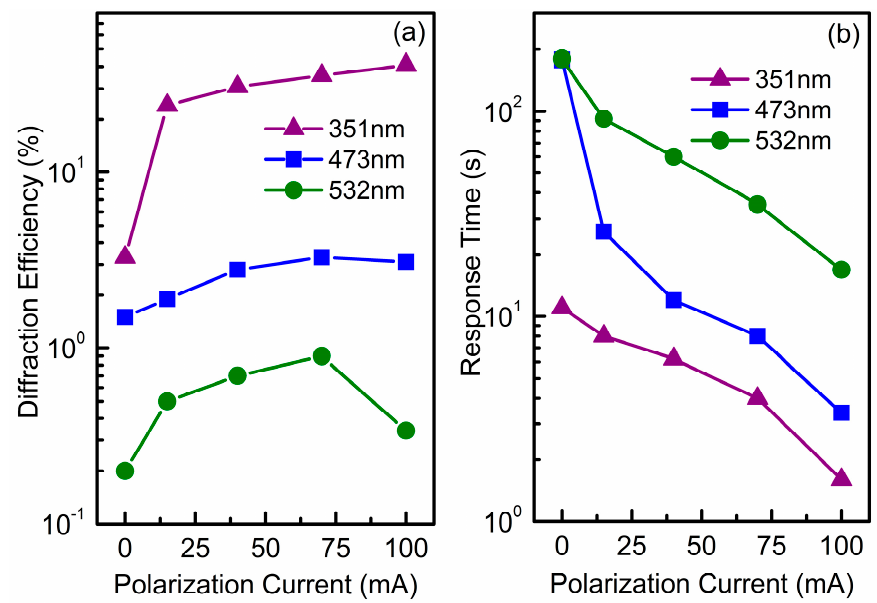
Figure 3. The UV-visible photorefractive ( a ) diffraction efficiency and ( b ) response time of CLN crystals polarized under various polarization currents. The light intensity per beam is 320, 400 and 400 mW/cm 2 for 351, 473 and 532 nm laser, respectively.